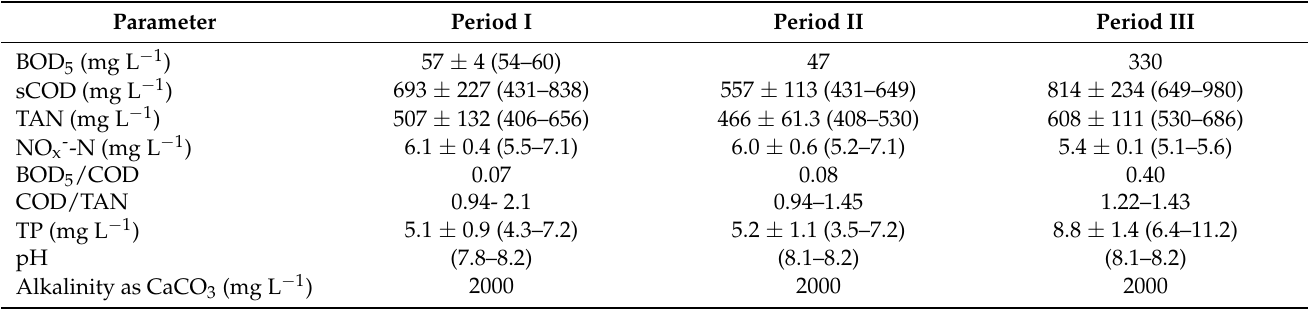
Table 2. Characteristics of the influent raw leachate in each experimental